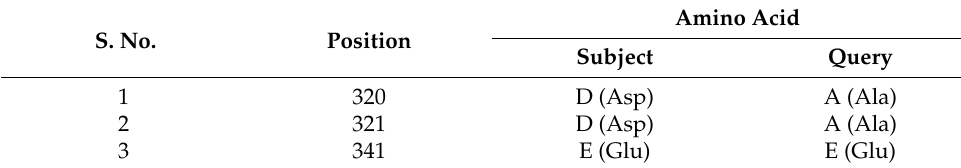
Table 7. Amino acid variation in subject and query protein sequences.